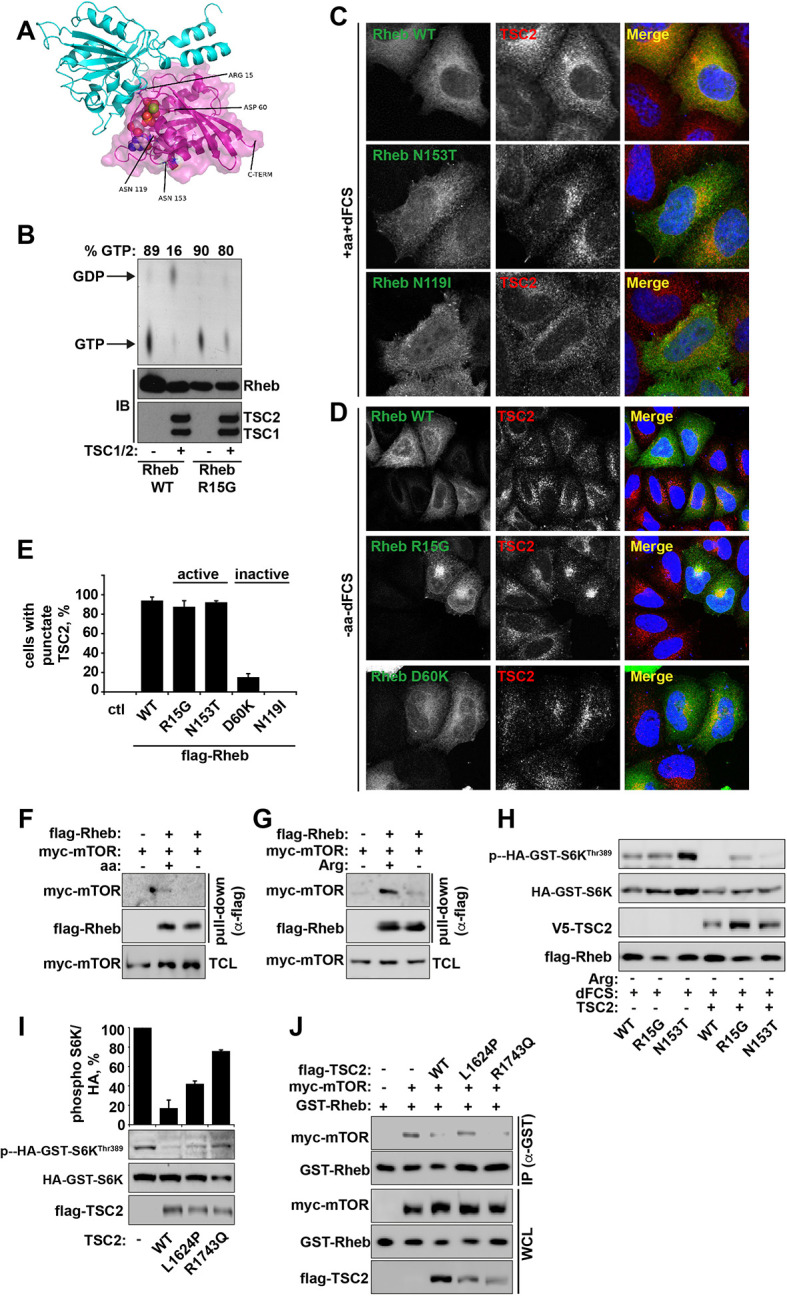
Arginine contributes to the regulation of Rheb activity by TSC2.(A) Model of the Rheb-TSC2 GAP domain complex, built using the human Rap1-Rap1GAP complex (pdb:3BRW) as a template. The TSC2 is in cyan cartoon representation, the Rheb is in magenta cartoon representation with a transparent molecular surface shown. The bound GTP is shown in spacefilling representation and the four key mutated Rheb residues, aspartic acid (Asp) 60, glutamine (Gln) 64, asparagine (Asn) 119, and asparagine (Asn) 153, are shown in stick representation. Note that these residues are not likely to perturb the interaction between Rheb and TSC2 directly. In addition, the location of the C-terminal membrane anchor of Rheb is shown. The figure was generated with PyMOL (Schrodinger, LLC). (B) Rheb R15G mutant is GTP-bound and largely insensitive to TSC2-dependent hydrolysis. Rheb wild-type and Rheb R15G were loaded with radiolabeled GTP prior to incubation with TSC2 for 60 min. GTP and GDP were eluted from Rheb and analyzed by thin-layer chromatography. Immunoblot (IB) samples demonstrate protein loading controls for Rheb, TSC1 and TSC2. (C) HeLa cells were transfected with Flag-tagged wild-type Rheb, active Rheb N153T, or inactive Rheb N119I for 24 hr. Cells (in full nutrient conditions) were fixed and immunostained with antibodies against TSC2 and Flag-tagged Rheb. (D) HeLa cells were transfected with Flag-tagged wild-type Rheb, active Rheb R15G, or inactive Rheb D60K for 24 hr. Cells were starved of amino acids and serum prior to fixation. Cells were immunostained with antibodies against TSC2 and Flag-tagged Rheb. (E) HeLa cells were transfected with active and inactive constructs described in C and D. The percentage of cells with punctate TSC2 was quantified in cells expressing Rheb mutants maintained in full nutrient conditions. (F, G) Amino acids, specifically arginine regulate the interaction between Rheb and mTOR. HeLa cells were transfected with Flag-wild-type Rheb overnight, lysed and loaded onto anti-Flag beads. HeLa cells transfected with myc-mTOR were subject to starvation protocols as indicated prior to lysis. Lysates were incubated with Rheb-loaded beads at 4°C. Samples were analyzed by immunoblotting to detect interaction of mTOR with Rheb. (H) TSC complex can inhibit Rheb-mediated mTORC1 activity independent of GAP activity. Cells were transfected with Flag-wild-type Rheb, Flag-Rheb R15G or Flag-Rheb N153T with Flag-TSC2 and HA-GST-tagged S6K overnight as in Figure 4H. Cells were subjected to arginine starvation in the presence of dFCS, prior to lysis and immunoblotted for phosphorylation of S6K. (I) HeLa cells were transfected overnight with wild-type or GAP-deficient TSC2 and HA-GST-tagged S6K. Cells were lysed and immunoblotted for phosphorylation of S6K. (J) HeLa cells were transfected with GST-Rheb either in the presence of mTOR and TSC2 constructs as indicated. Lysates were subjected to pull-down with glutathione Sepharose beads and interaction between Rheb and mTOR was analyzed by immunoblot. All graphs represent an average of at least two independent experiments and error bars represent standard deviation. Scale bars: 10 μm.